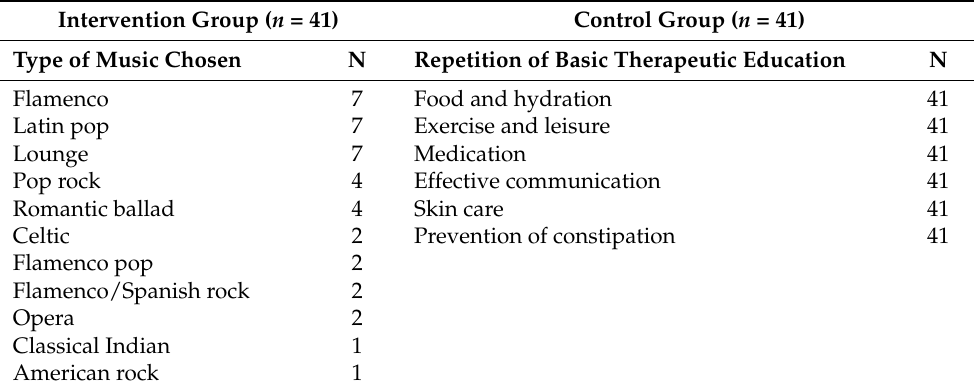
Table 1. Audio content for the intervention and control groups of family caregivers. Intervention Group ( n =